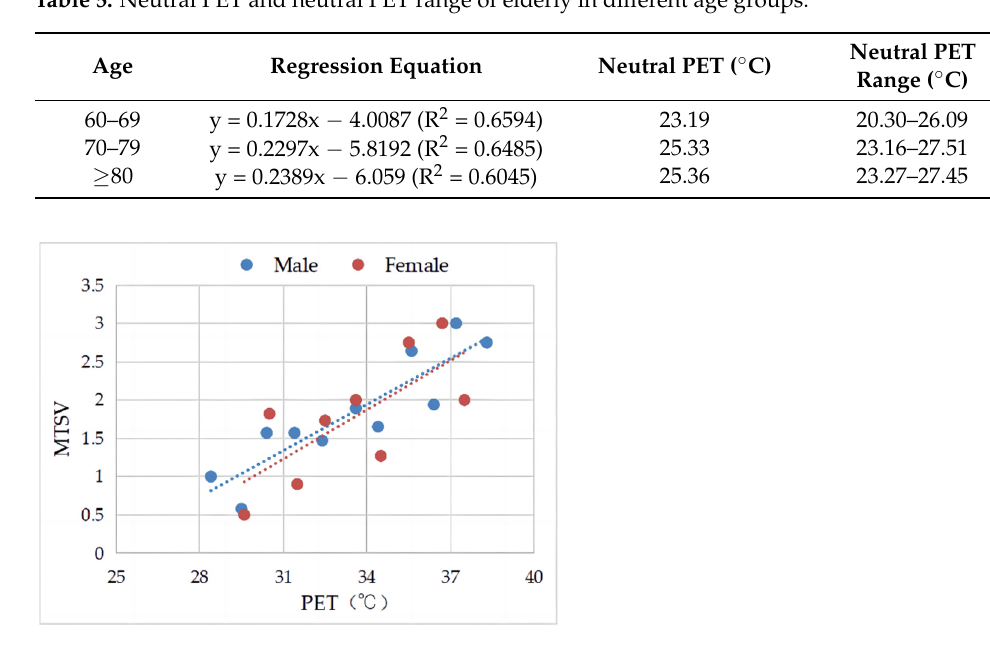
Table 5. Neutral PET and neutral PET range of elderly in different age groups.